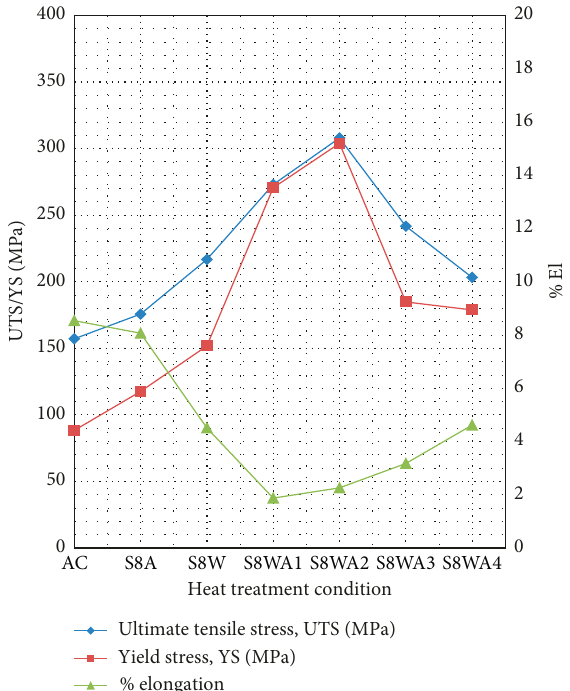
Figure 7: Average values of UTS, YS, and %El obtained at 250 ° C, for alloy B in the as-cast condition, and after heat treatments comprising SHT for